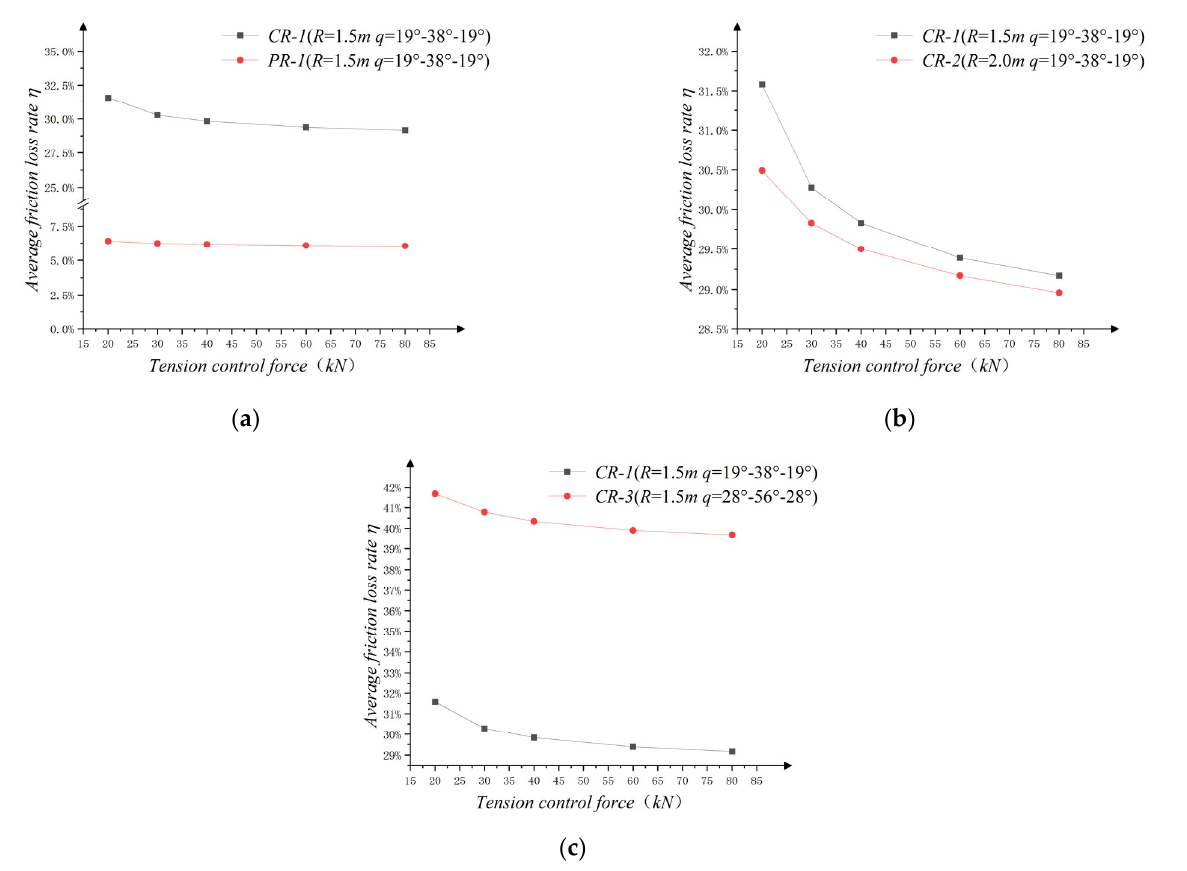
Figure 10. Comparison of data from three ‐ continuous ‐ bending tests: ( a ) comparison group of CR ‐ 1 and PR ‐ 1(different μ only); ( b ) comparison group of CR ‐ 1 and CR ‐ 2 (different R only); ( c ) comparison group of CR ‐ 1 and CR ‐ 3 (different θ only).